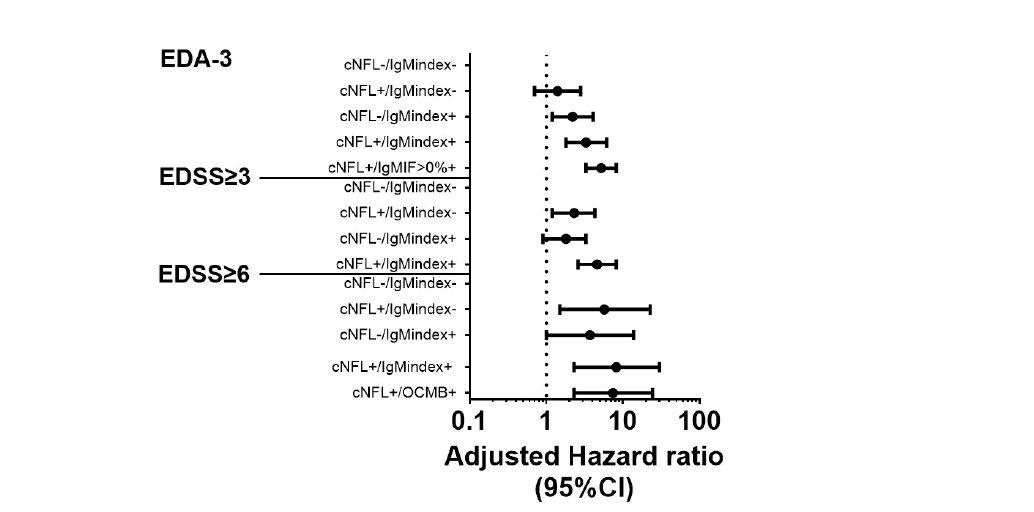
FIGURE 4 Combination of baseline cNFL and ITMS to predict EDA-3, EDSS ≥ 3, and EDSS ≥ 6. Forest plot with adjusted hazard ratios for risks of achieving EDA-3 status within 24 months, EDSS ≥ 3, and EDSS ≥ 6, strati fi ed by combinatory possibilities of cNFL and ITMS. cNFL, cerebrospinal fl uid neuro fi lament light; ITMS, intrathecal IgM synthesis; EDA, Evidence of Disease Activity; IgM, immunoglobulin M; IF, intrathecal fraction; OCMB, oligoclonal IgM band; EDSS, expanded disability status scale; Ig, immunoglobulin; CI, con fi dence